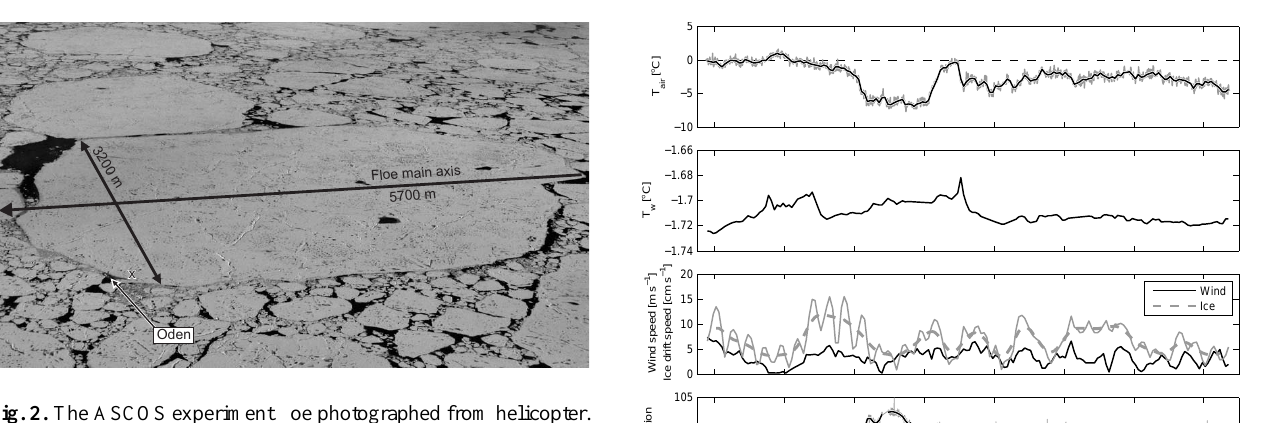
Fig. 2. The ASCOS experiment floe photographed from helicopter. Length and width are estimated from mapping of ice floe from he- licopter. The orientation of the floe’s main axis is calculated from simultaneous GPS measurements at the ship and on the floe. The cross indicates the site of the ocean measurements.